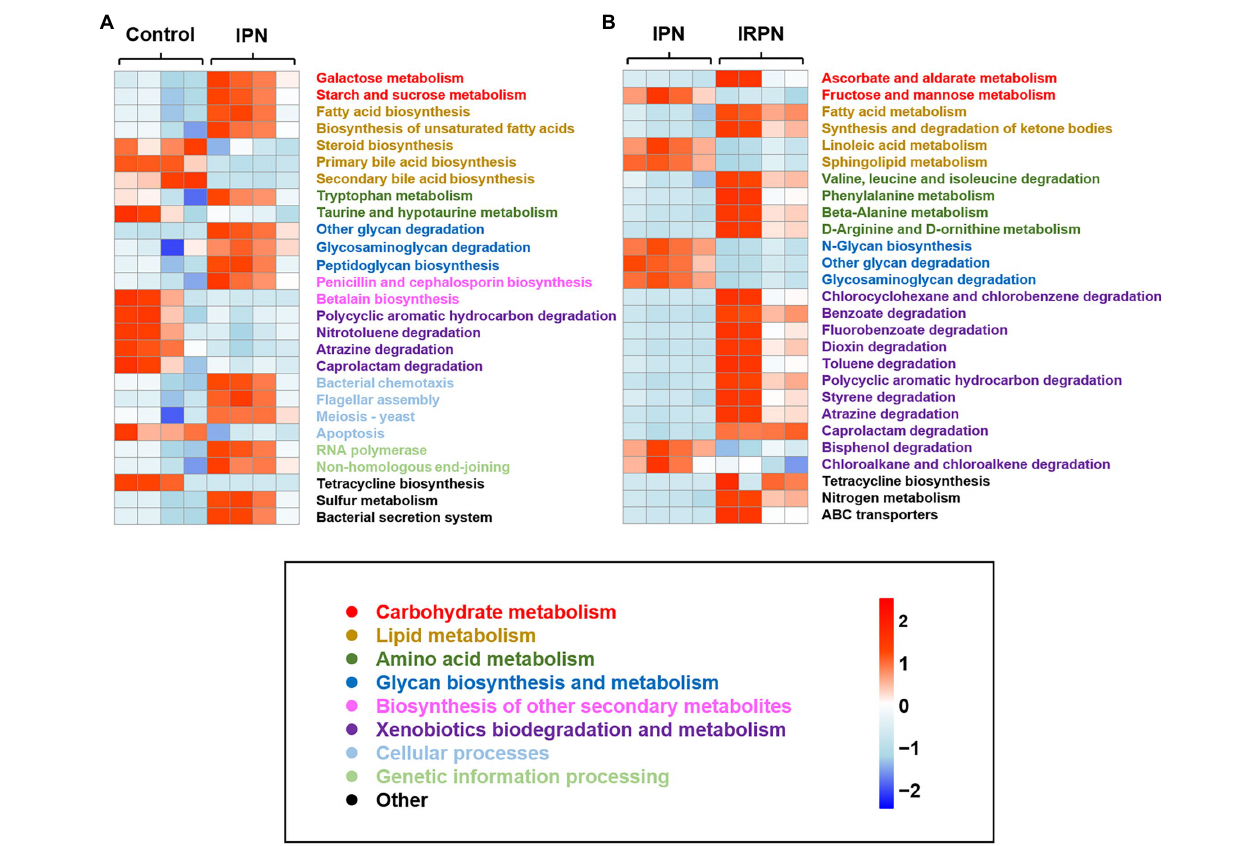
FIGURE 7 | Heat map of the relative abundance of key functional gene families predicted by PICRUSt of control and IPN (A) and IPN and IRPN (B) . Gene families are coloured according to functional